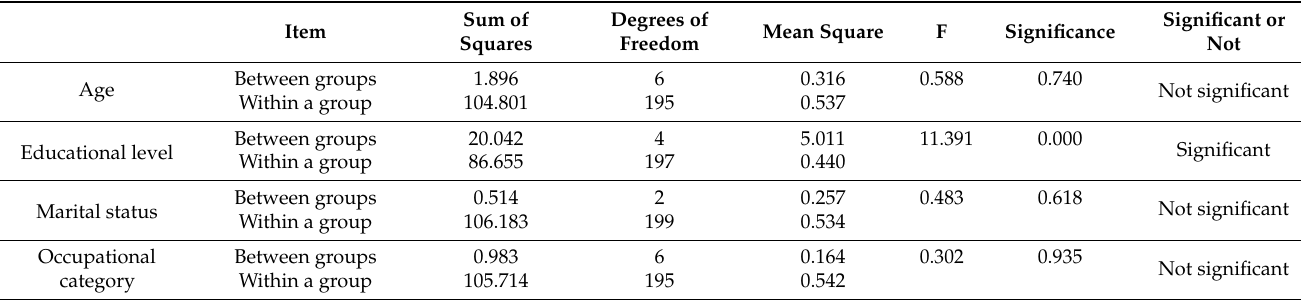
Table 10. ANOVA analysis of external variable perceived usefulness.